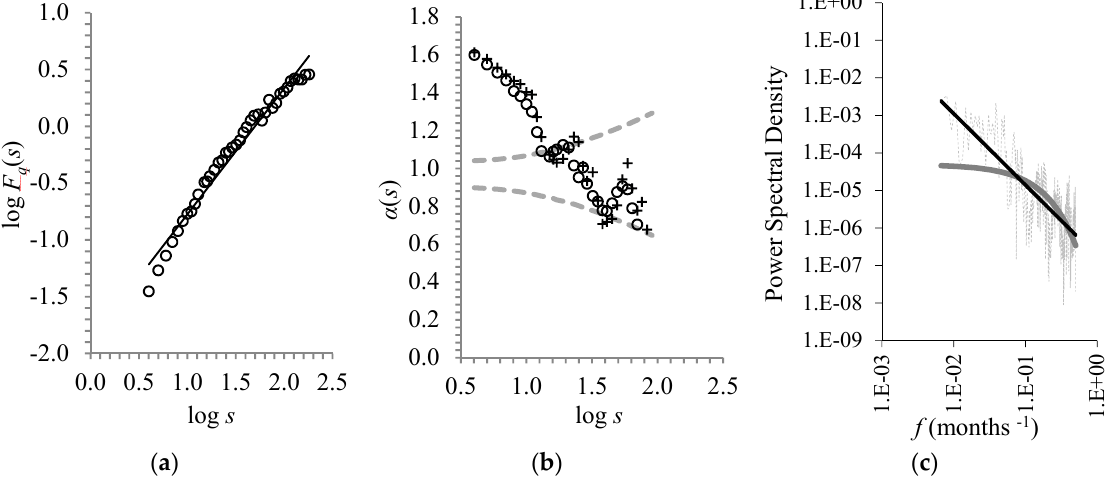
Figure 4. As in Figure 2, but for the detrended and deseasonalized CST time-series. ( a ) The best fit equation was y = 1.1x – 1.88 ( R ² = 0.97). ( b ) The mean value of the local slopes was 𝑎 ̅ = 1. ( c ) The power-law fit (black line) was y = 2·10 –7 ·x –1.90 ( R ² = 0.53) and the exponential fit (grey line) was y = 5·10 –5 ·e –9.9x ( R ² = 0.39).